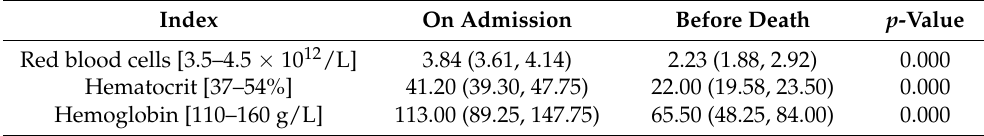
Table 4. Biochemical outcomes from “on admission” and “before